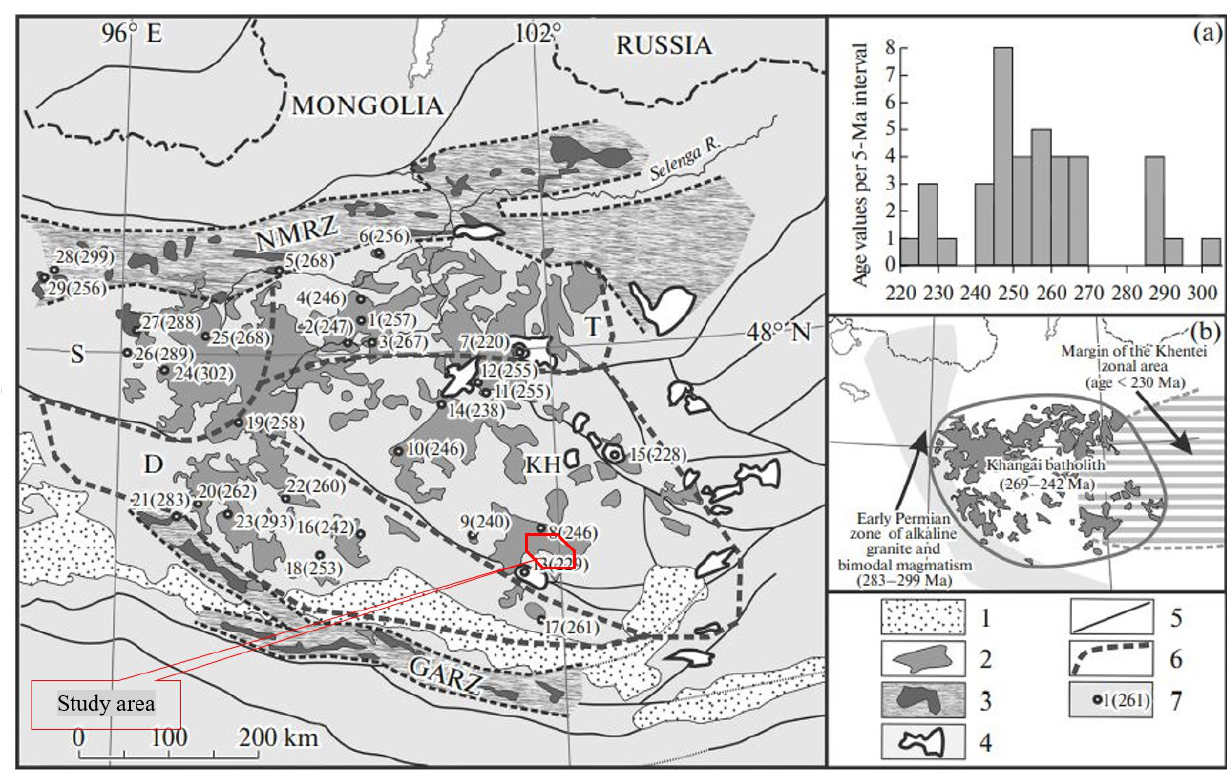
Fig. 1. Schematic geological map of the Khangai zonal magmatic area (Yarmolyuk et al., 2016). Legend: (1) Mesozoic and Cenozoic depressions; (2) granitoid massifs of the Khangai batholith; (3) rift zones (GARZ is the Gobi Altai rift zone and NMRZ is the northern Mongolian rift zone) and exposed bimodal volcanic associations and alkaline granites; (4) Late Triassic volcanic fields and granitoid massifs; (5) faults; (6) boundaries among the continental blocks or terranes (S-Songino, D-Zavkhan, T-Tarvagatai, KH-Khangai); (7) sampling sites for isotopic dating. (a) histogram showing the distribution of age values of granitoids in the Khangai batholith area; (b) schematic map showing the distribution of magmatic areas of various ages in the vicinity of the Khangai